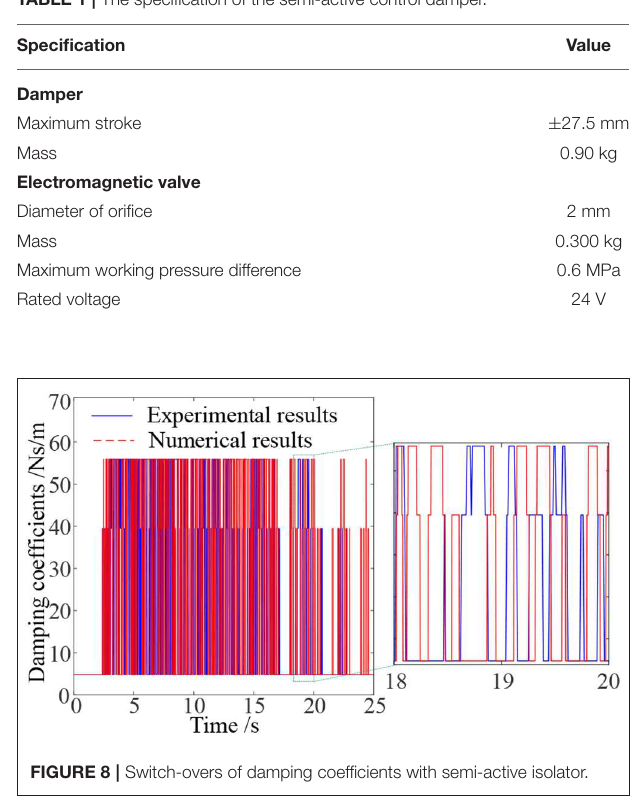
FIGURE 8 | Switch-overs of damping coefficients with semi-active isolator.